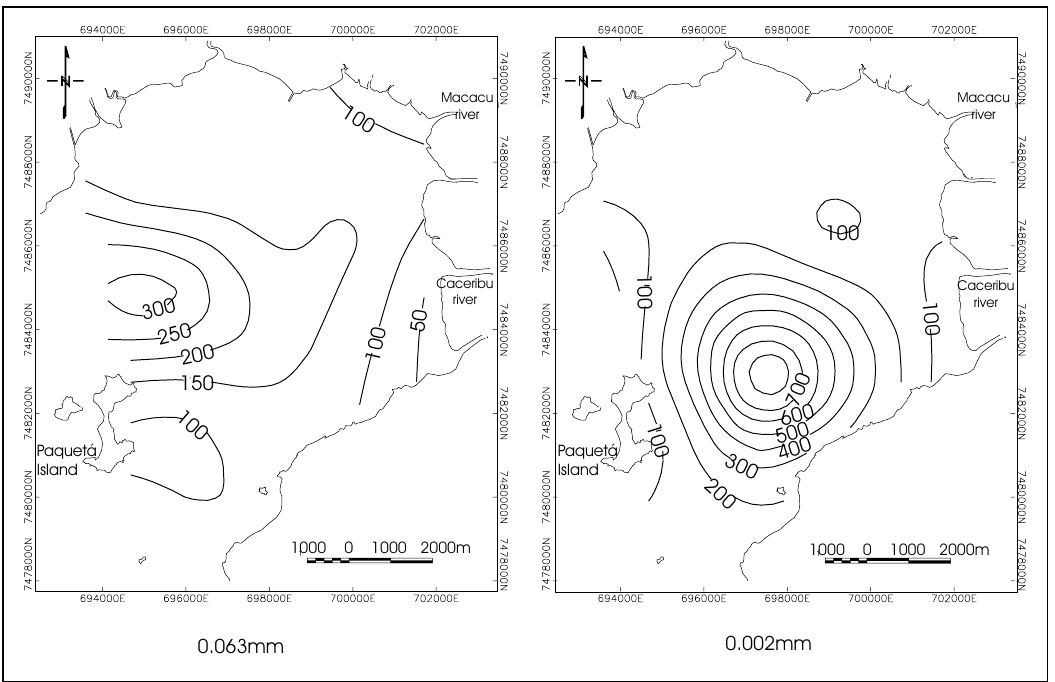
Fig. 6 – Cu distribution in bottom sediments of northeastern Guanabara Bay (contour lines are in